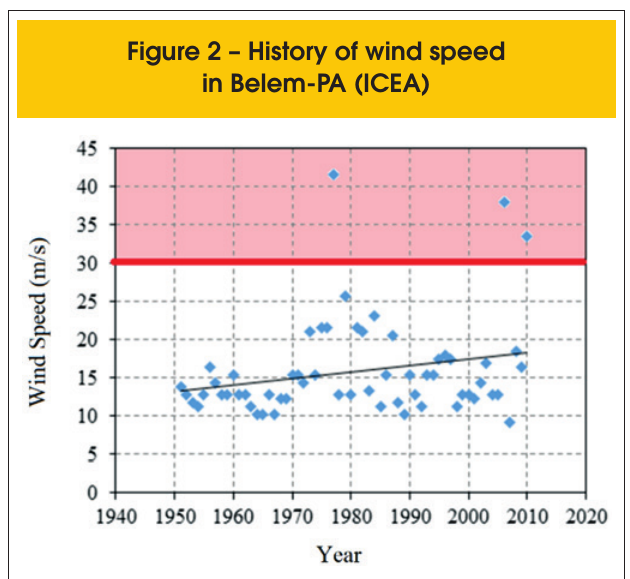
Figure 2 – History of wind speed in Belem-PA